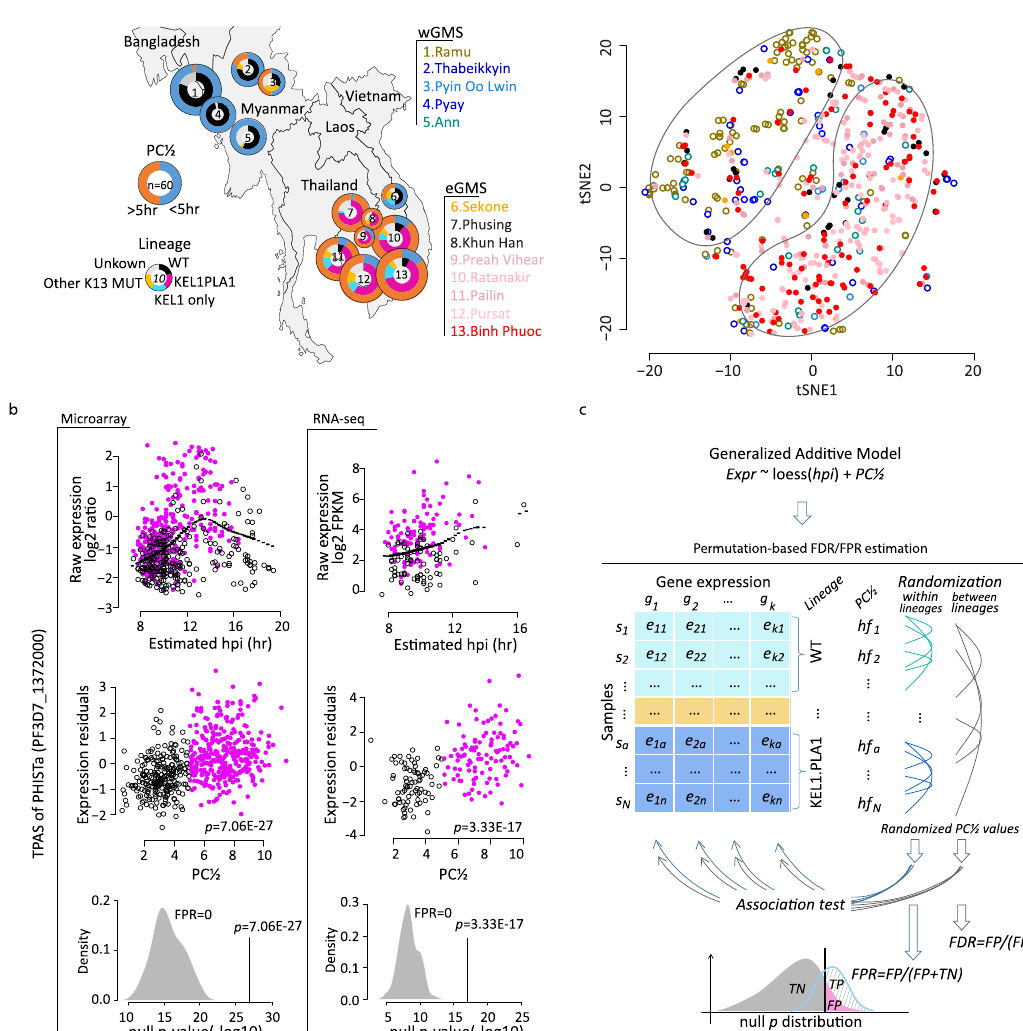
Fig. 1 Transcriptome of TRACII P. falciparum parasite population and a schematic illustration of the TPAS methodology. a Geographic distribution of all samples used in this study. Pie charts represent the proportion of slow (PC½ > 5 h) and fast (PC½ < 5 h) clearing parasites, or lineages in categories based on PfK13 mutations and plasmepsin II/III copy numbers (WT, KEL1 only, KEL1PLA1, other PfK13 MUT and unknown). On the right, 577 samples before drug treatment are plotted to display two main clusters formed by the eGMS or wGMS parasites geographical distribution using t-SNE algorithm based on the top 2-12 PCs. b TPAS explanation using an example gene of PHISTa (PF3D7_1372000). The expression-hpi/age relationship is shown as the raw expression level (log2 ratio) plotted against the estimated hpi for the microarray data on the left (577 samples) and RNA-seq data on the right (188 samples) with purple dots representing resistant parasites (PC½ > 5 h), black circles for susceptible parasites (PC½ < 5 h) and black dotted lines for the loess curve using all dots. The expression-resistance relationship is represented by the expression residuals plotted against the PC½ for each data set. The density plots at the bottom represent 100 times permutation result within lineages for the FPR calculation. c Work fl ow of FDR and FPR estimation for the TPAS. The null p distribution was built using permutated resistance status (PC½ values) across parasite samples within lineages for FPR estimation and between lineages for multiple testing